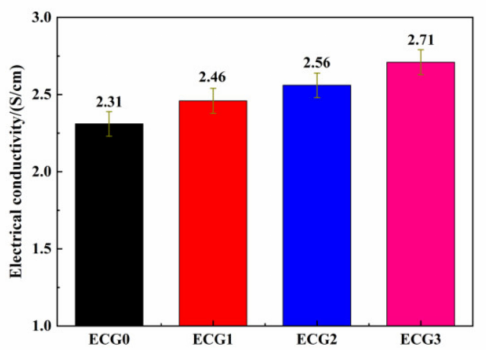
Figure 4. Electrical conductivity of CNT/GNP/EUG